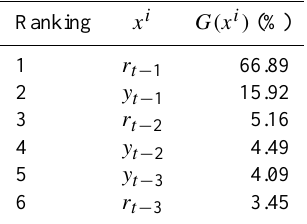
Table 4. Input Ranking results for the Marina catchment dataset (average over 10 data groups). The initial variance is